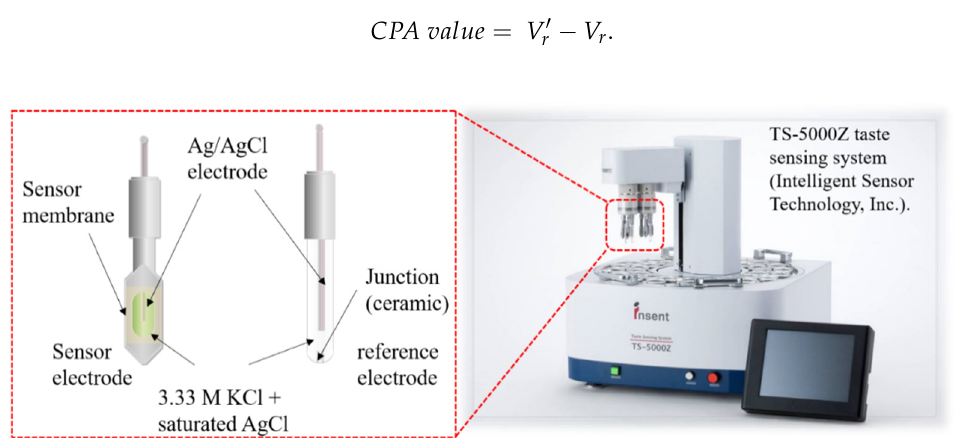
Figure 3. Experimental setup of taste sensor system.